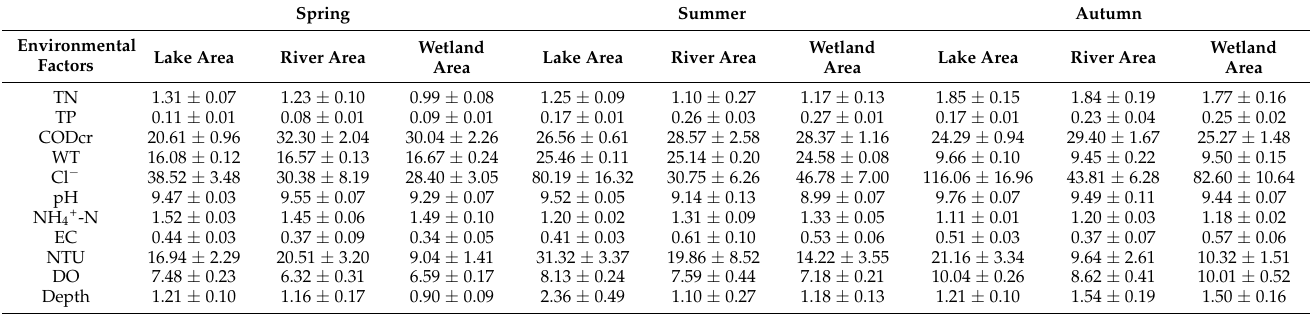
Table 3. Spatial distribution of mean values( ± SE) of environmental factors within Zhalong